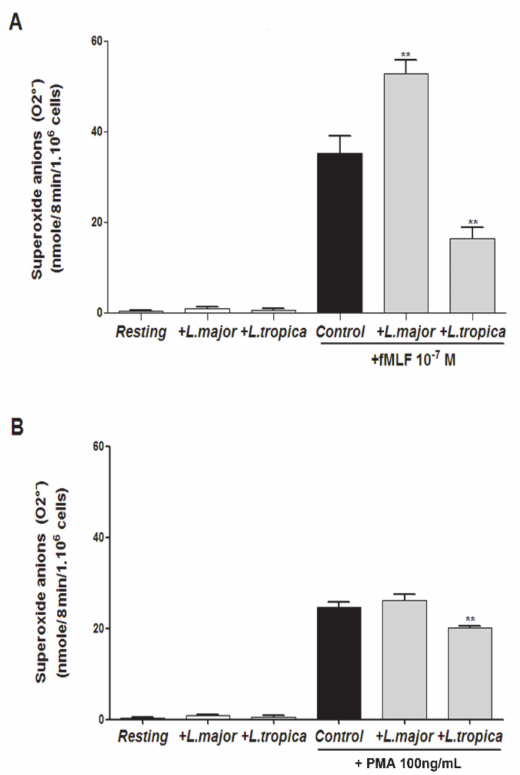
Figure 2. Effect of L. major and L. tropica promastigote strains on O 2 − production by human PMNs. PMNs (10 6 /mL) were infected at 5:1 ratio for 20 min at 37 ◦ C. The cells were incubated in the presence or absence of fMLF (10 − 7 M) or PMA (100 ng/mL). As a control, uninfected and nonstimulated PMNs (Resting), and uninfected and stimulated PMNs (Control) were used. Superoxide anion production was measured by the SOD-inhibitable cytochrome C reduction assay by the end-point method. The superoxide anion production was expressed as nmole/min/10 6 cells in the presence or absence of fMLF ( A ), or PMA ( B ). Results are expressed as mean ± SEM from three independent experiments, each performed in duplicate. Data were analyzed using a one-way ANOVA test with Tukey’s post-hoc test for multiple comparisons. ** p <